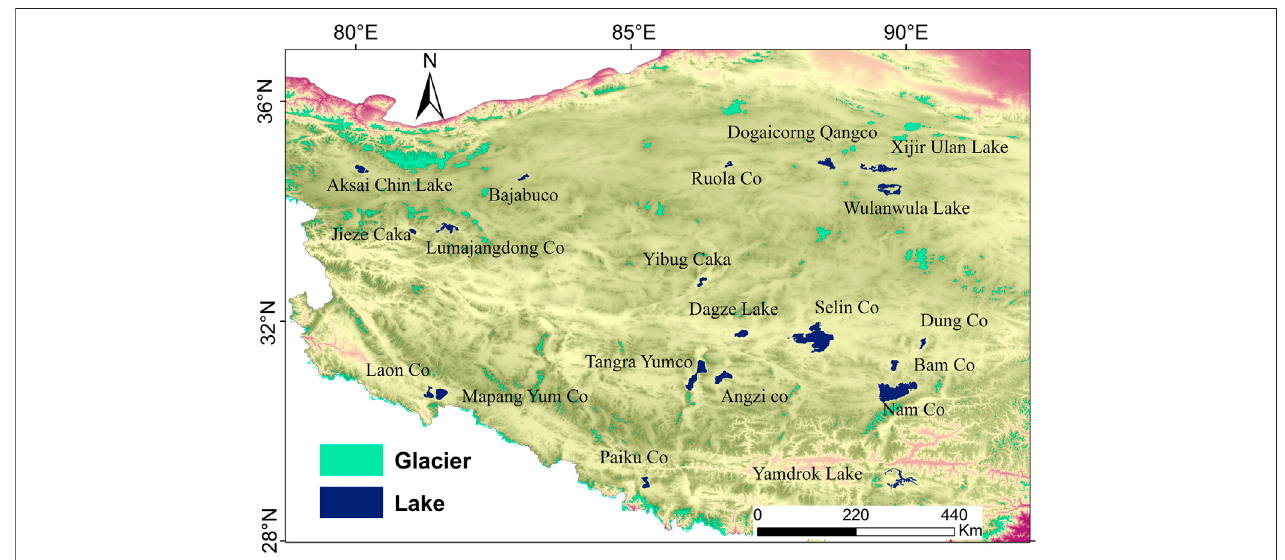
FIGURE 1 | Position of the studied lakes on TP and the relationships of the lakes with glaciers.